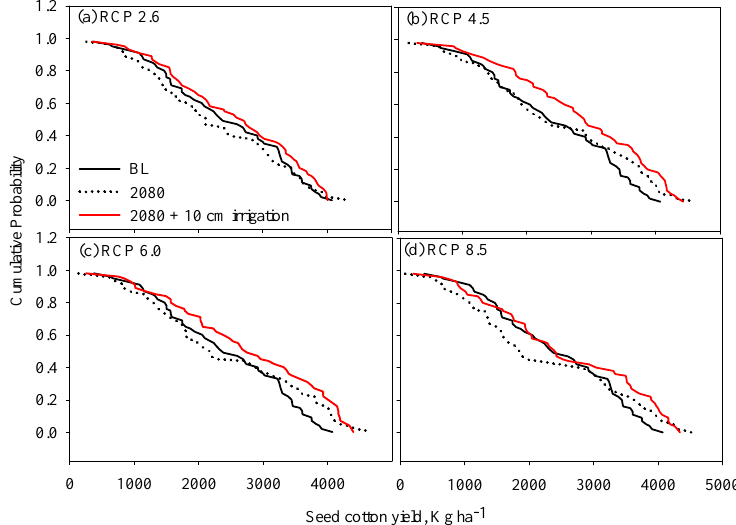
Figure 15. Comparison between the simulated rainfed seed cotton yield under baseline (BL) climate and climate change (CC; changes in CO 2 , temperature, and rainfall) in 2080 under RCP 2.6 ( a ), 4.5 ( b ), 6.0 ( c ), and 8.5 ( d ) for normal day of planting (2 May) with normal planting plus 10 cm irrigation.